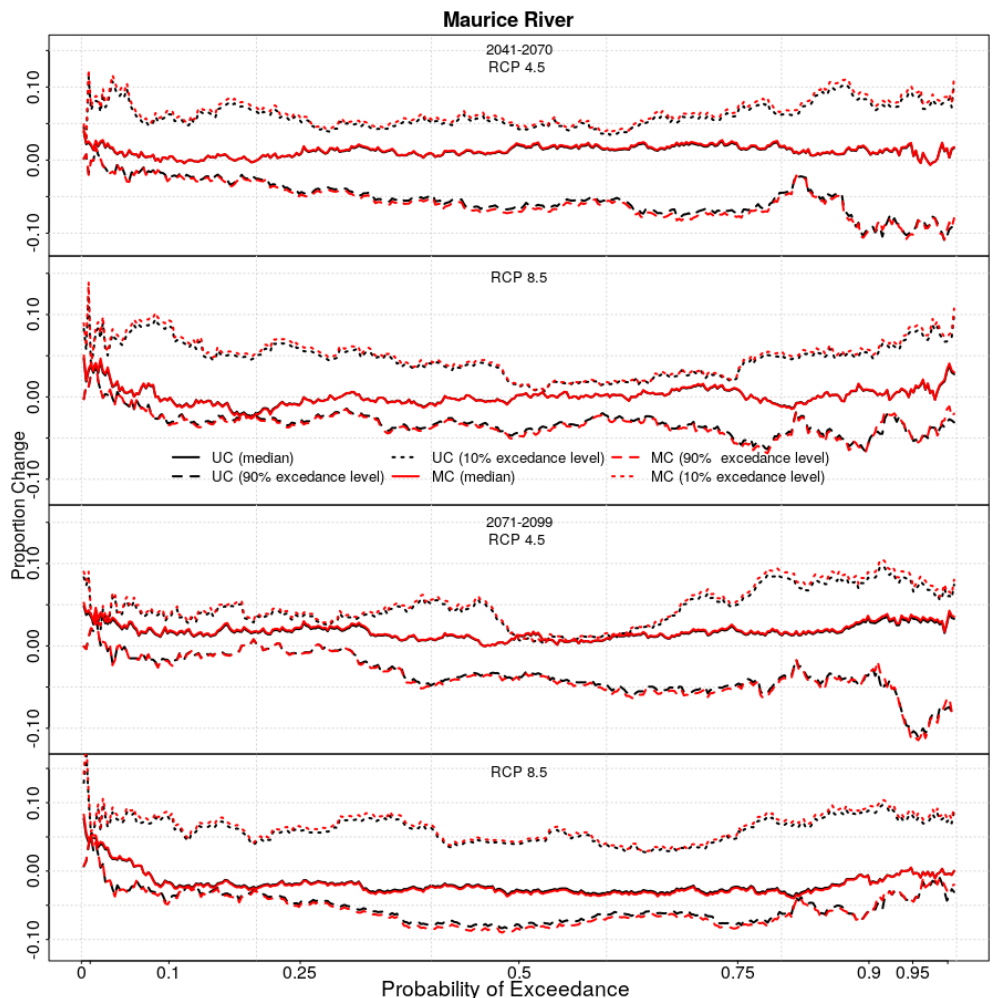
Figure 13. Projected change in stream flows as indicated by the proportional change in stream flow at each exceedance level of the FDC for the Maurice River. Projected change in flow is shown for each RCP for uncorrected (UC) and model-corrected (MC) GCM